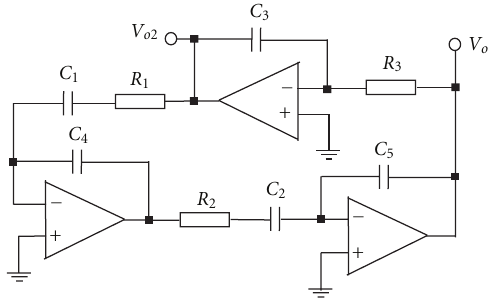
Figure 2: The second proposed quadrature oscillator